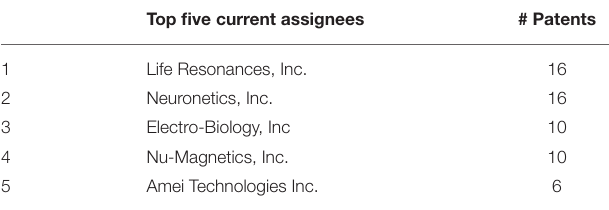
TABLE 4 | Top current assignees in the magnetic energy-based therapeutic domain. Top five current assignees